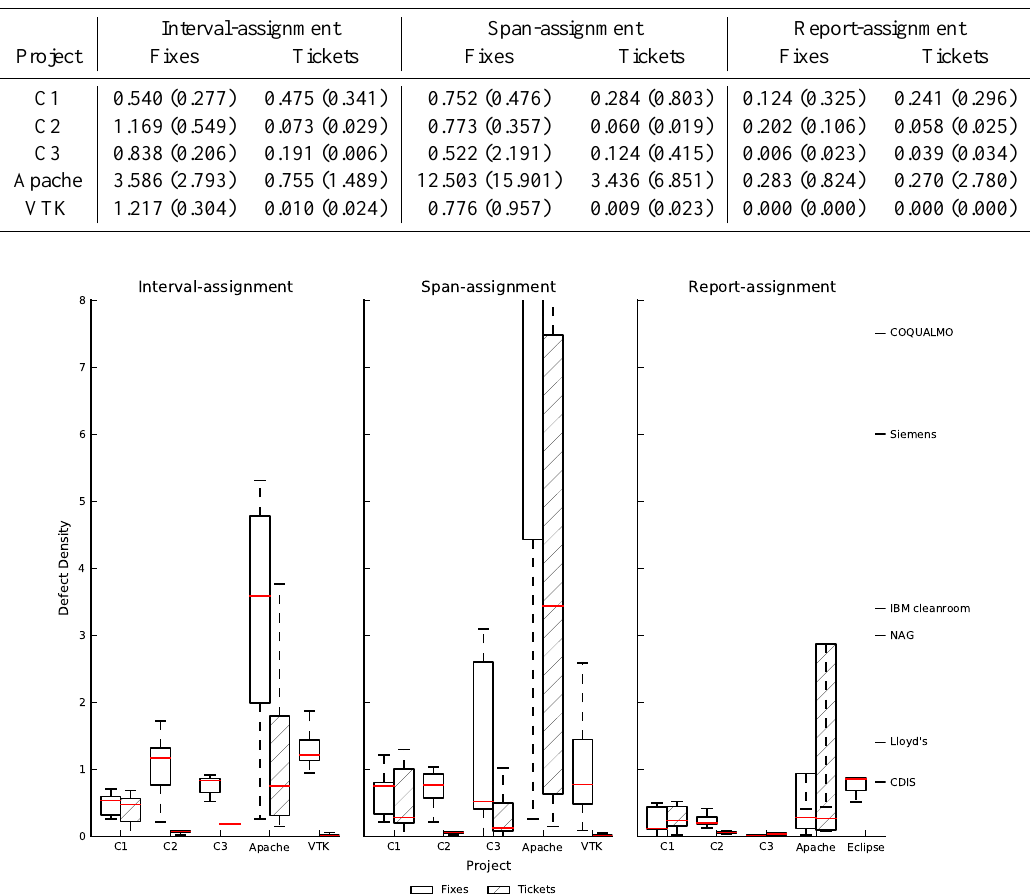
Fig. 4. Defect density of projects by defect assignment method. Previously published defect densities from Table 1 are shown on the right.